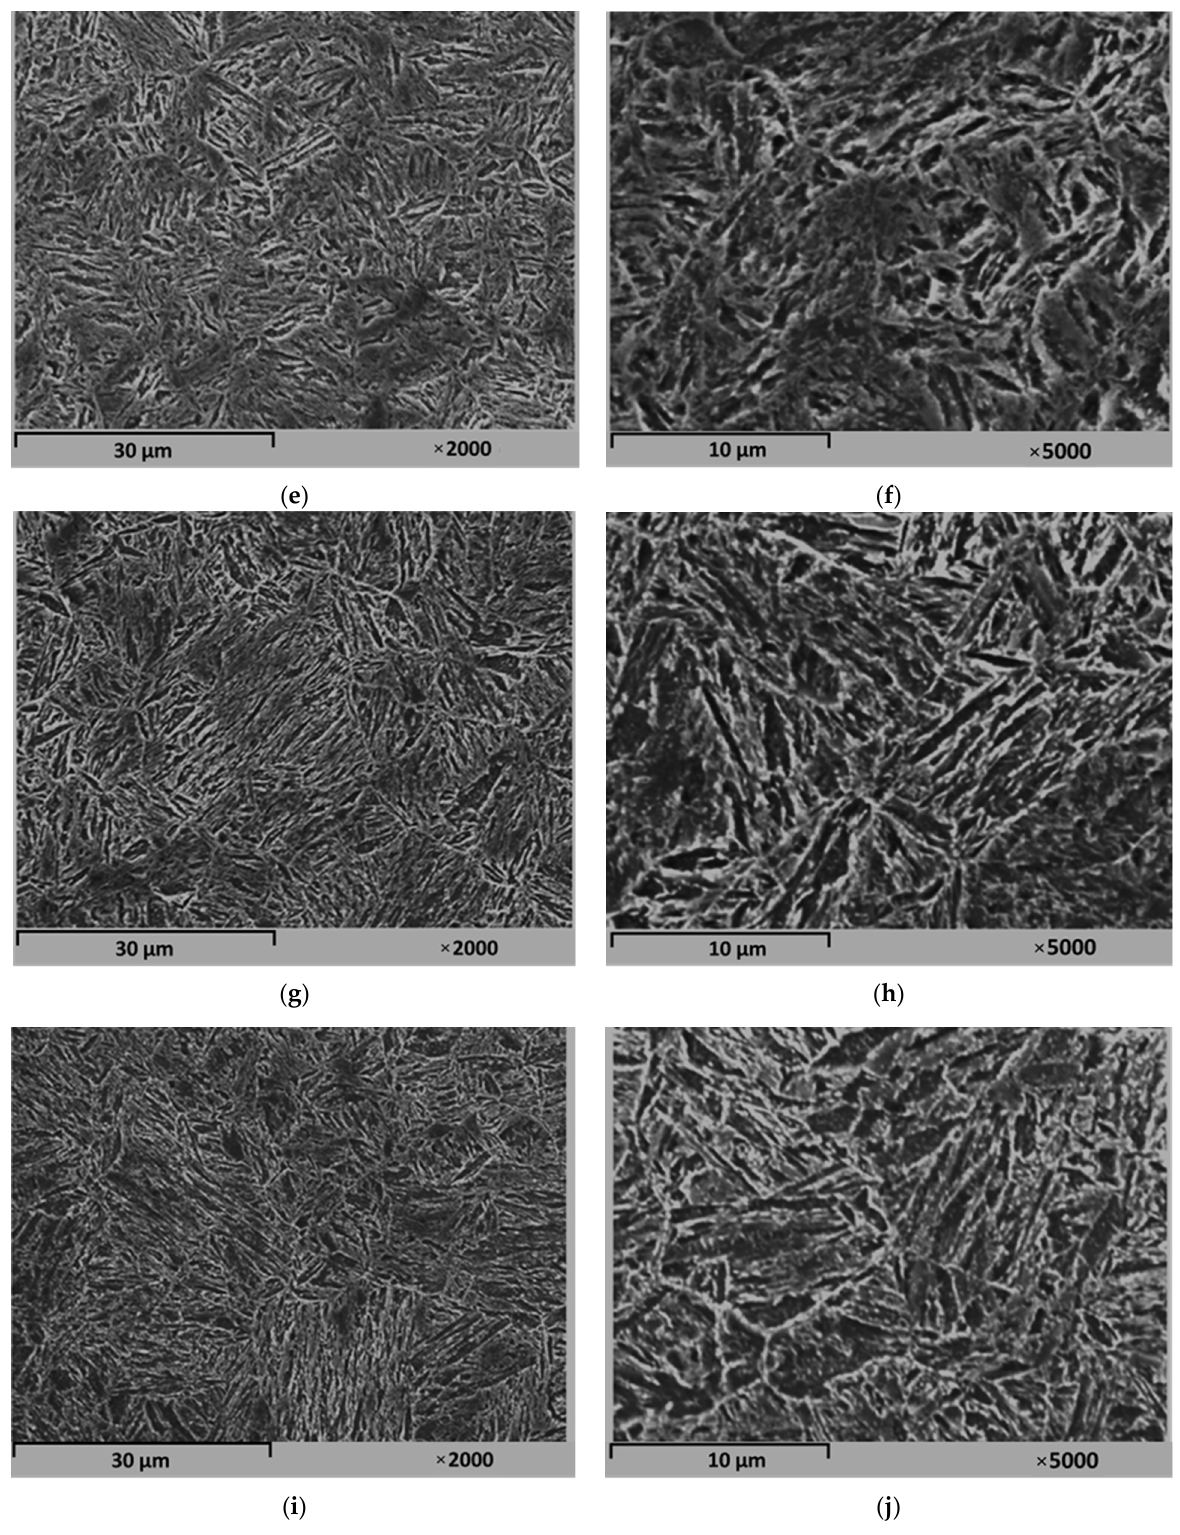
Figure 3. Microstructure of a round-rolled sample made of 40KhN2MA grade steel after quenching and tempering for 1 h at a temperature of: ( a , b ) 400 °C; ( c , d ) 425 °C; ( e , f ) 450 °C; ( g , h ) 500 °C; and ( i , j ) 550 °C. Arrows point to carbides.